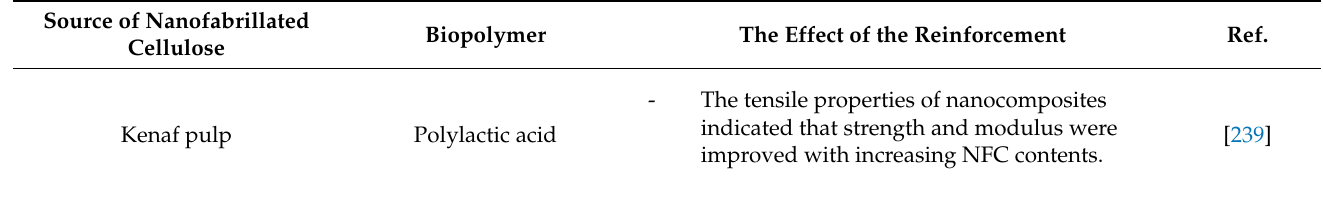
Table 4. Illustration of the effect of nanofibrillated cellulose on the biopolymer matrix. Source of Nanofabrillated